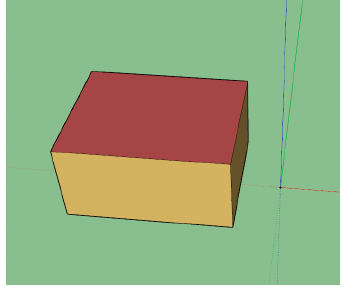
Figure 7. Cases of study: ( a ) Scenario 1; ( b ) Scenario 2; ( c ) Scenario 3.